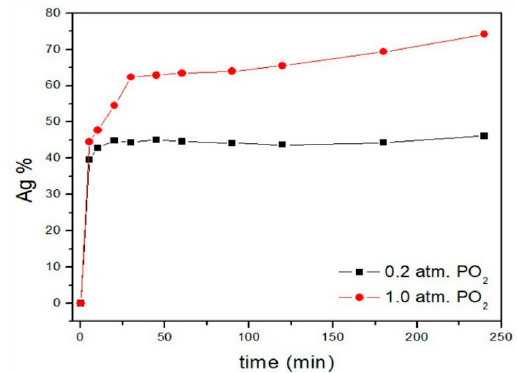
Figure 7. Effect of partial pressure of oxygen on the leaching reaction of silver (V = 0.5 L, 40g L − 1 Mineral, pH = 10, leaching time = 240 min, [S 2 O 32 − ] = 0.16 mol L − 1 , [Cu 2+ ] = 0.006 mol L − 1 , 298 K (25 °C), 32 − ] = 0.16 mol · L − 1 , [Cu 2+ ] = 0.006 mol · L − 1 , 298 K RPM = 750 min − 1 ). Mineral, pH = 10, leaching time = 240 min, [S 2 O (25 ◦ C), RPM = 750 min − 1 ).